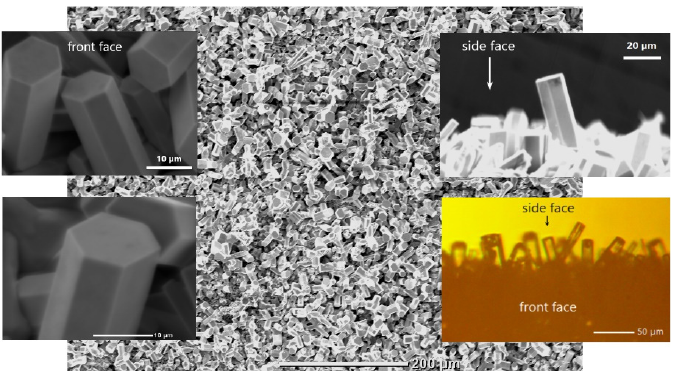
Figure 1. Microphotographs of an ensemble of ZnO microcrystals. The left insets show SEM images of ZnO microcrystals formed on the front face of the sample. The right insets show images obtained by SEM (upper) and optical microscopy (bottom) of the edge region of the sample—individual microrods oriented in space are seen on the side face of the sample.